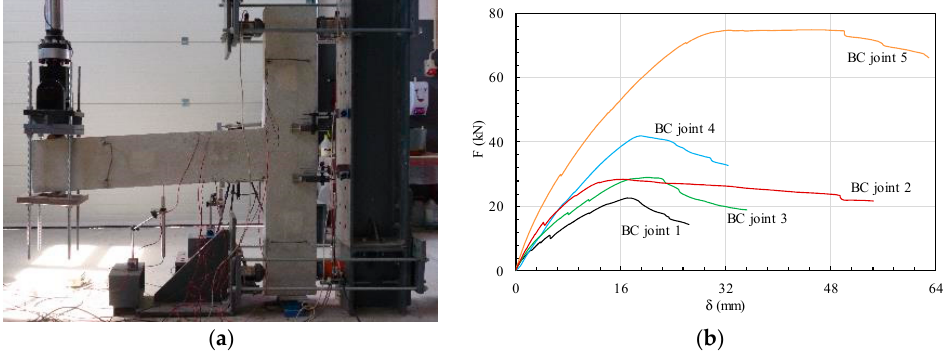
Figure 4. ( a ) View of test set-up; ( b ) Load—displacement at the edge of the beam.